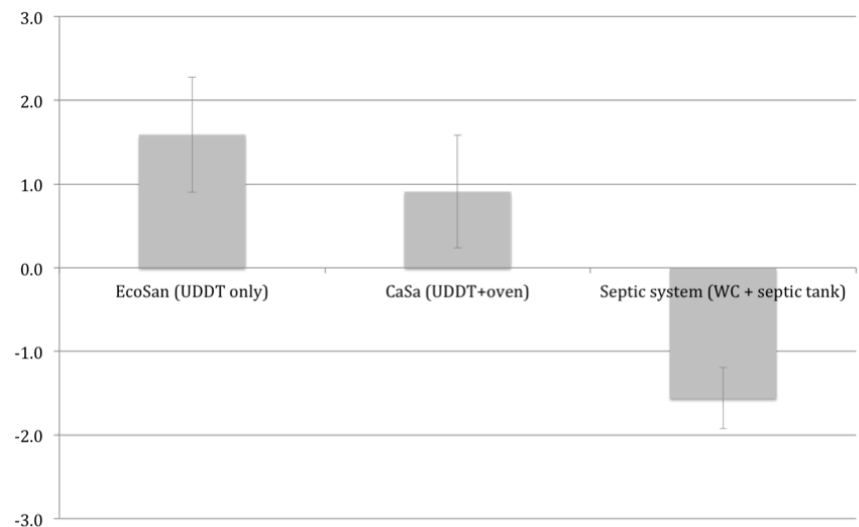
Figure 6. The overall sustainability index (SI) of sanitation alternatives analysed, presented as mean value of all participants and in ranked order. The SI-values range from − 10 to + 10 (cf. Table 4). Grey bars indicate the standard error of the mean